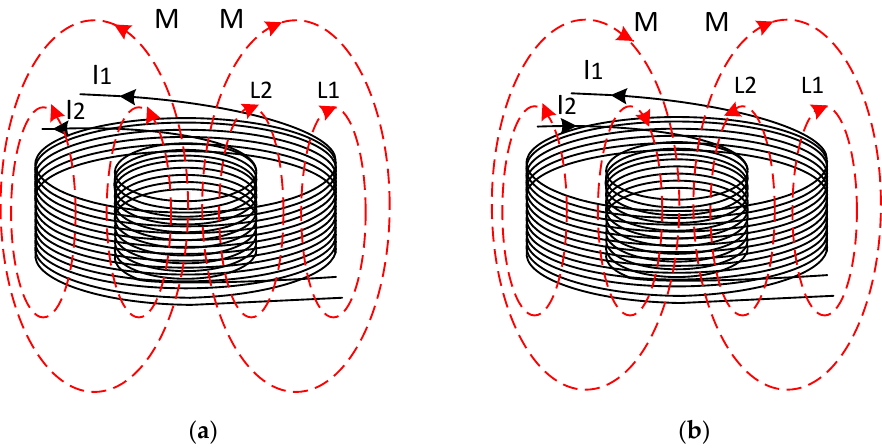
Figure 4. Schematic diagram of the influence of mutual inductance between multiple coils on magnetic field coupling: ( a ) Two sets of coils pass current in the same direction; ( b ) Two sets of coils pass current in opposite directions.